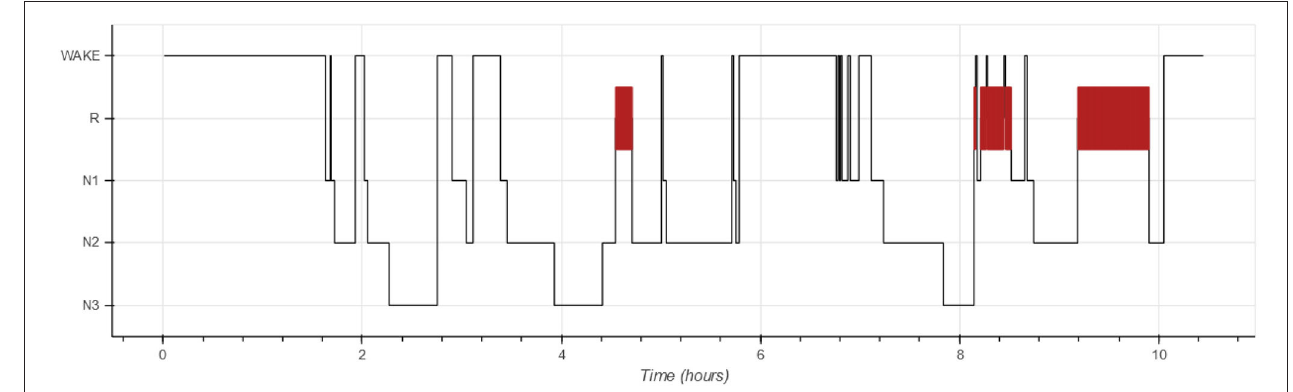
FIGURE 1 | Example of a hypnogram scored by an